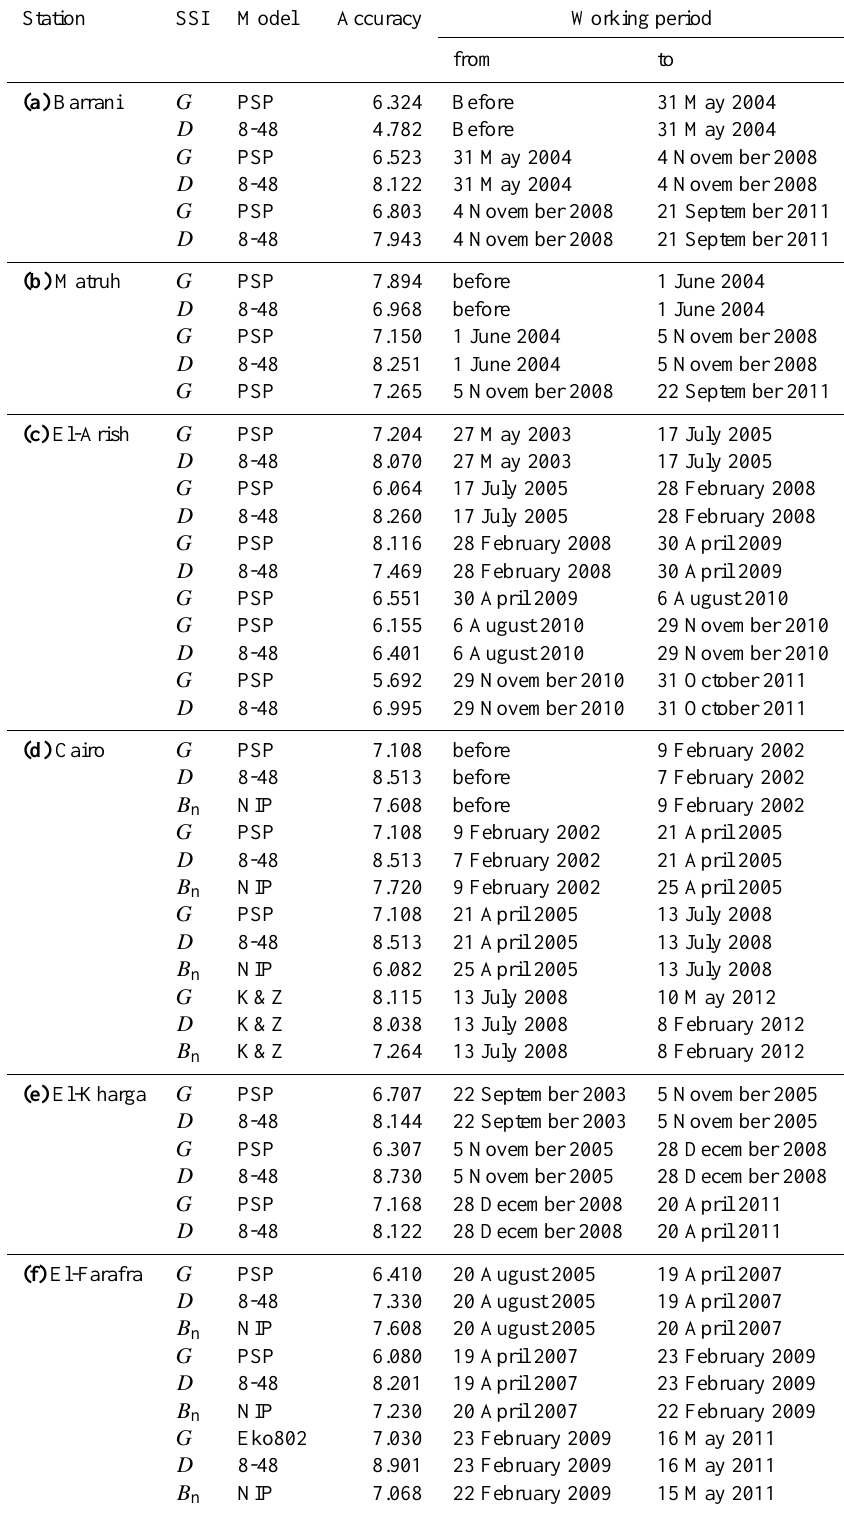
Table 2. Details of the set of instruments implemented at the eight experimental sites. Their accuracy (in mVcal − 1 cm − 2 min − 1 ) and working periods are also